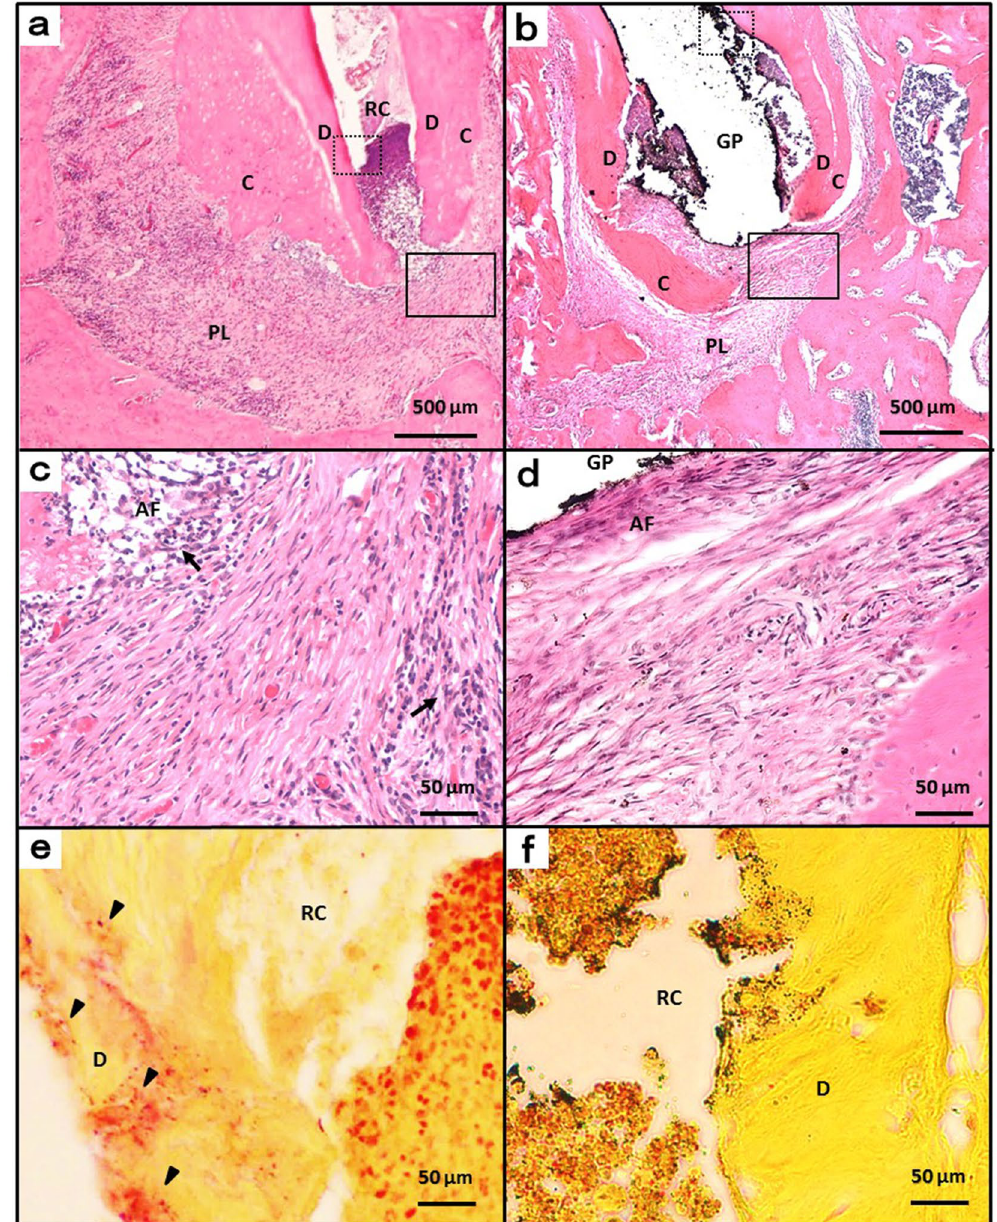
magnification views of the solid inset in panels a and b, respectively. ( e and f ) High-magnification views of the dotted insets in panels b and e, respectively, stained with a modified Brown and Brenn method. AF, apical foramen; GP, gutta-percha point; RC, root canal; C, cementum; D, dentin; PL, periapical lesion; arrow head, bacteria; arrow, inflammatory